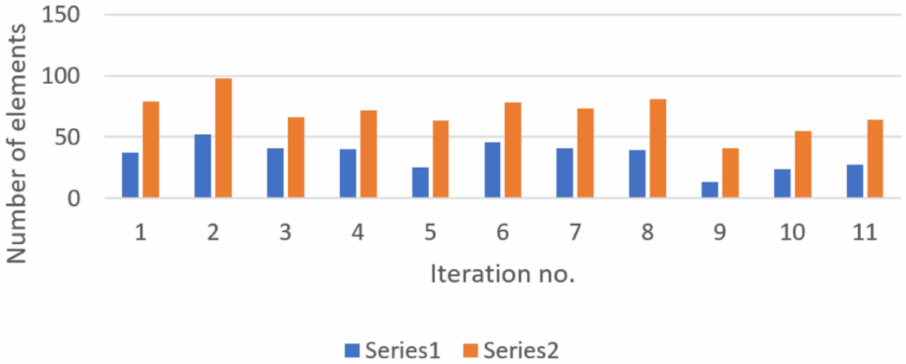
Figure 7. Detected devices (represented in blue—Series 1) versus real number of persons (represented in orange—Series 2) present in trains (traveling in